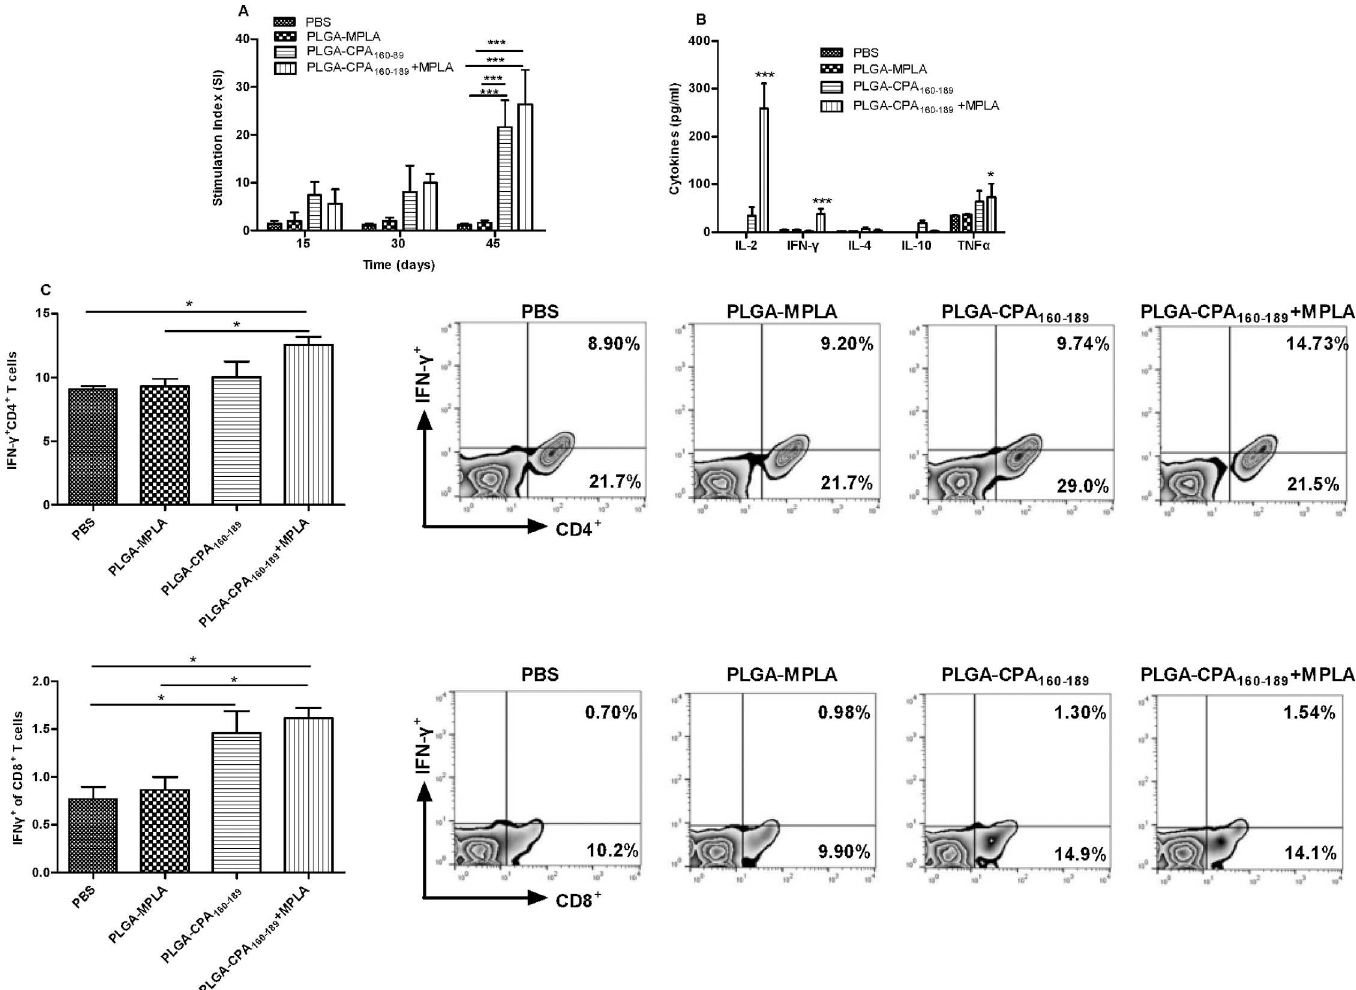
Fig 5. Determination of CPA 160-189 -specific cellular responses in PLGA NPs-vaccinated mice. (A) CPA 160-189 -specific proliferation of spleen cells obtainedfrom mice vaccinatedat different time points. Control group was vaccinated with PBS. Results are expressed as mean stimulationindex (S.I.) ± SD from three independentexperiments. (B) CPA 160-189 -specific IL-2, IFN- γ , IL-4, IL-10 and TNF α productionfrom spleen cells isolated two weeks after the end of vaccinationsfrom vaccinated and non-vaccinated mice. (C) Diagramshowingdetectionof CPA 160-189 -specific IFN- γ production by CD4 + and CD8 + T cells by flow cytometry analysiswith representativedot plots, two weeks after the end of vaccinations. Results are presented as means ± SD of five individualmice per group, representative of two independentexperiments with similar results. * p < 0.05, ** p < 0.01, *** p < 0.001for proliferation and cytokine assays were assessedby two-way ANOVA and Bonferroni’s multiple comparison tests, whereasflow cytometry results were assessedby one-wayANOVA and Tukey’s